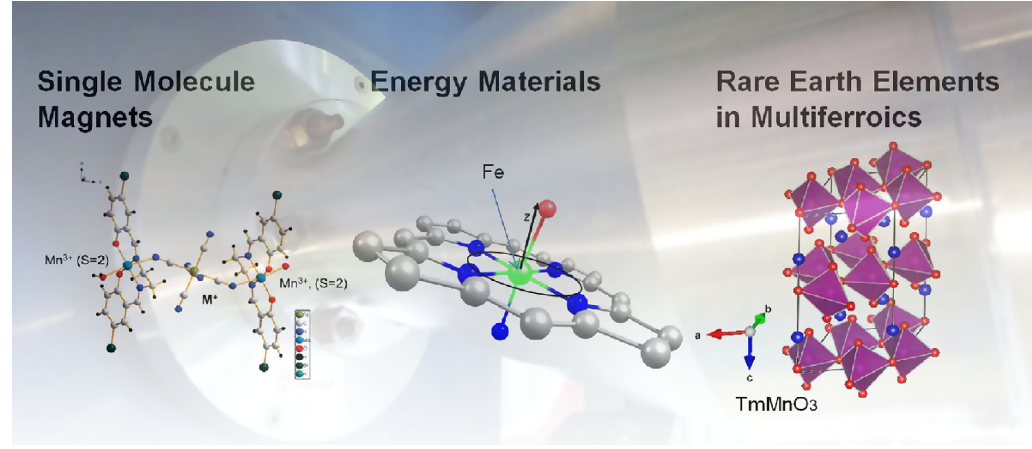
Figure 3: Examples for systems studied by FD-FT THz-EPR at BESSY